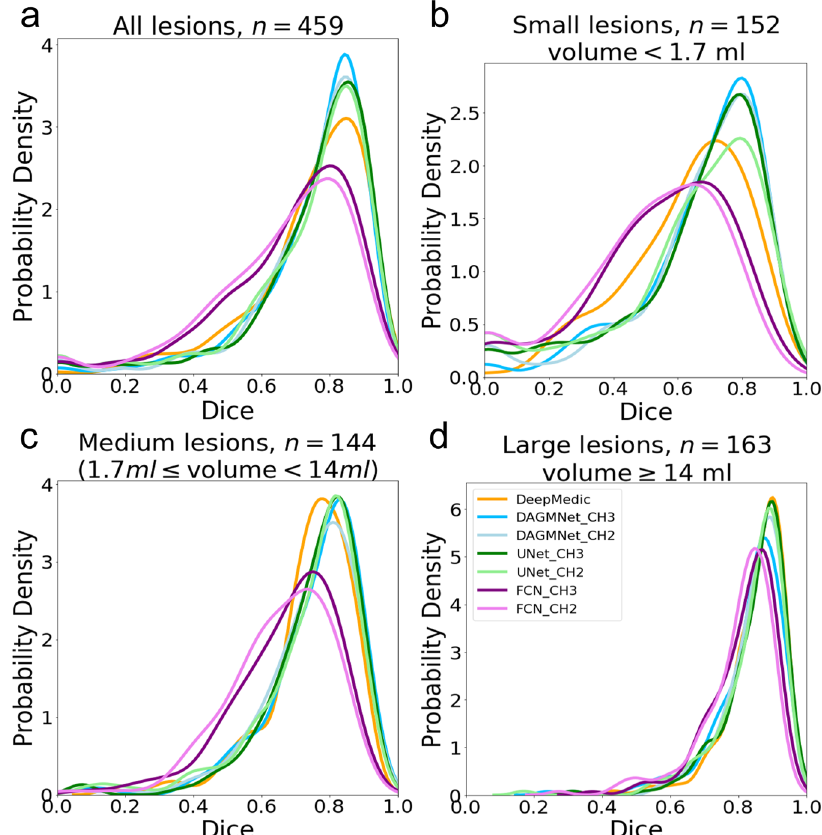
Fig. 4 The probability density of the Dice score. The probability density ( y axis) of the Dice score of different models in the Testing dataset; ( a ) is for all subjects; ( b ), ( c ), and ( d ) are strati fi ed by the lesion volume. All the sub- fi gures share the same legends as the sub- fi gure ( d